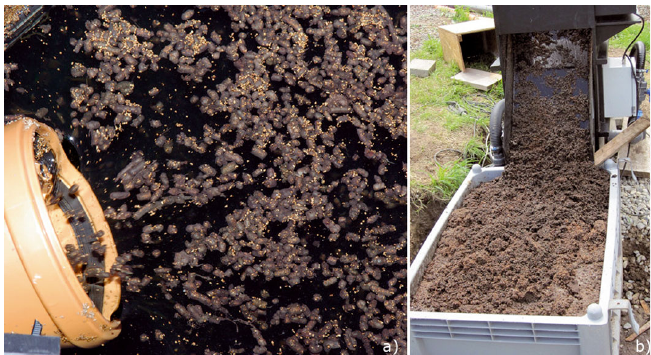
Fig. 4. (a) Floating faeces with cork granulae (lighter, reddish par - ticles) entering the outlet pipe and (b) faeces being collected and transported by the surface separator to a sludge